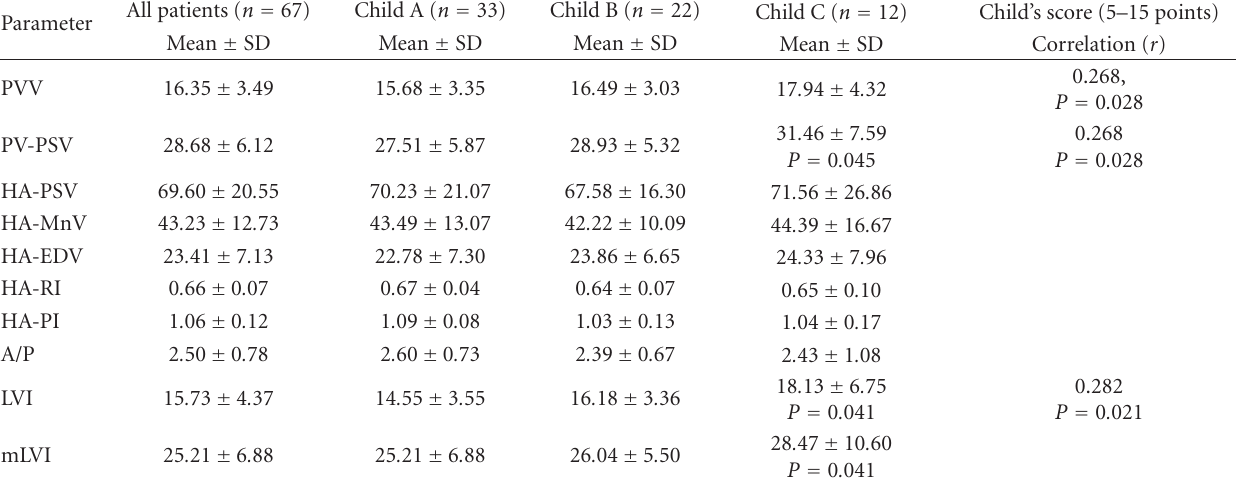
Table 2: Liver Doppler US parameters in patients with liver cirrhosis according to Child-Pugh classification.